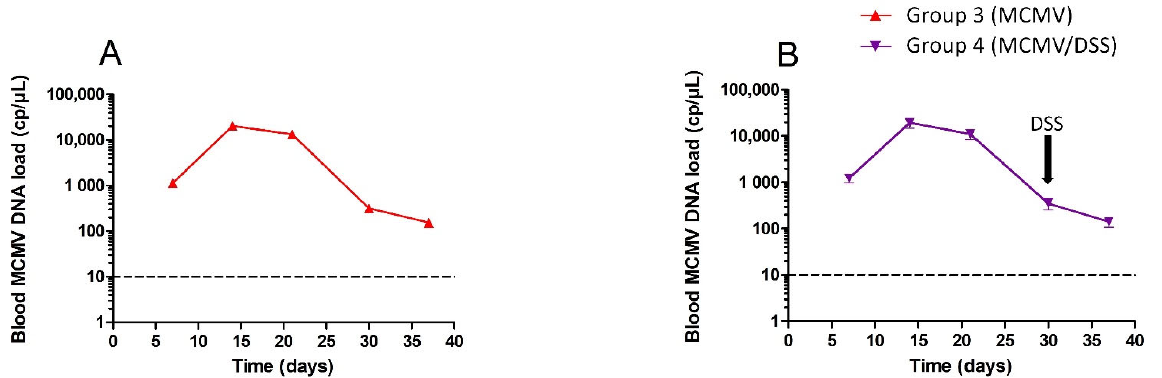
Figure 2. Kinetics of blood MCMV DNA load measured by qPCR for infected mice. Group 3 (red curve, ( A )) and group 4 (purple curve, ( B )). D0 corresponds to the time of infection with MCMV and D37 represents the time of sacrifice. The arrow denotes the beginning of dextran sodium sulfate (DSS) treatment in group 4. The limit of PCR quantification is represented by the horizontal line. The statistical test that was used was a two-way ANOVA with Bonferroni correction for panels. Standard variations are too low to be seen in the figures.